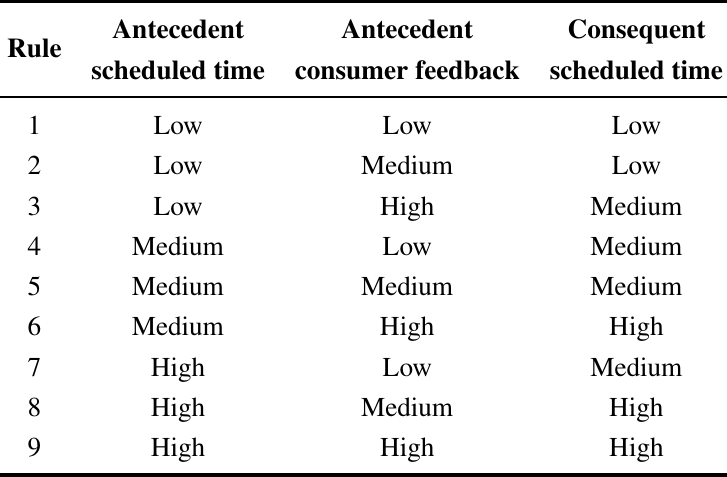
Table 3. Inference rules for the new scheduled